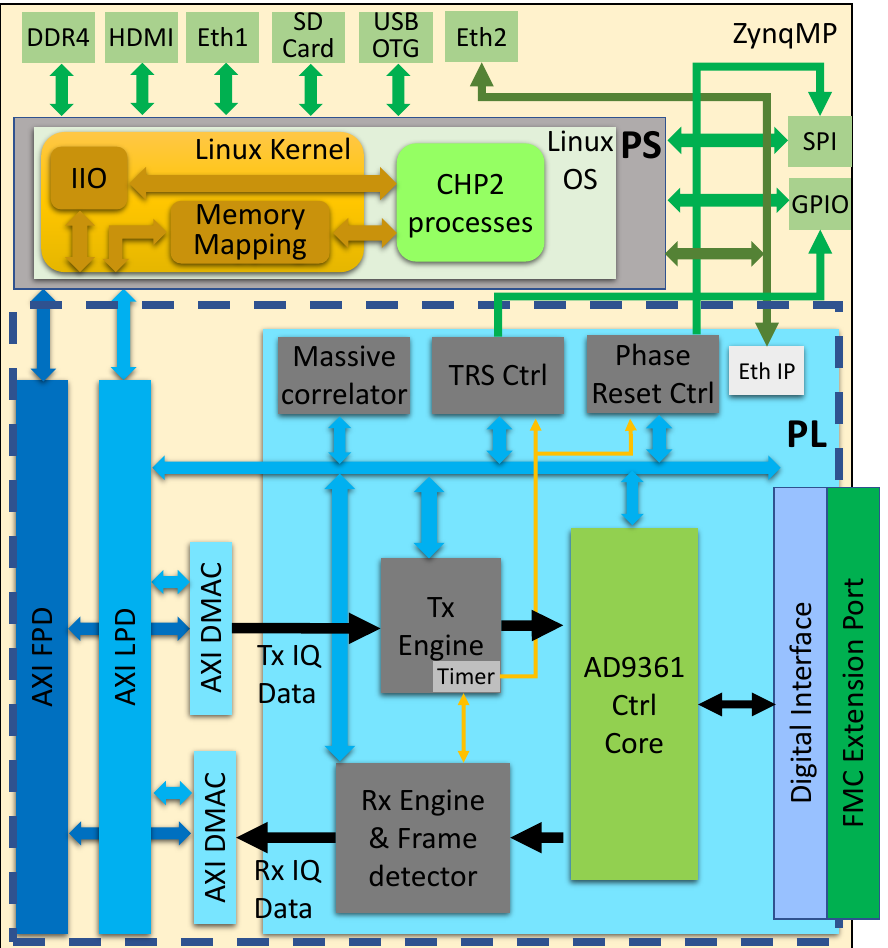
Figure 14. CHP2 processing architecture on the ZynqMP platform. In the PL section, the critical timing components and massive mathematical tasks are implemented as HDL IP cores. In the PS section, the light tasks are implemented as processing programs running over the ARM Cortex-A53 cores. Except for the AD9361 control core and DMAC blocks that come from the ADI SDR architecture, the remaining blocks are fully